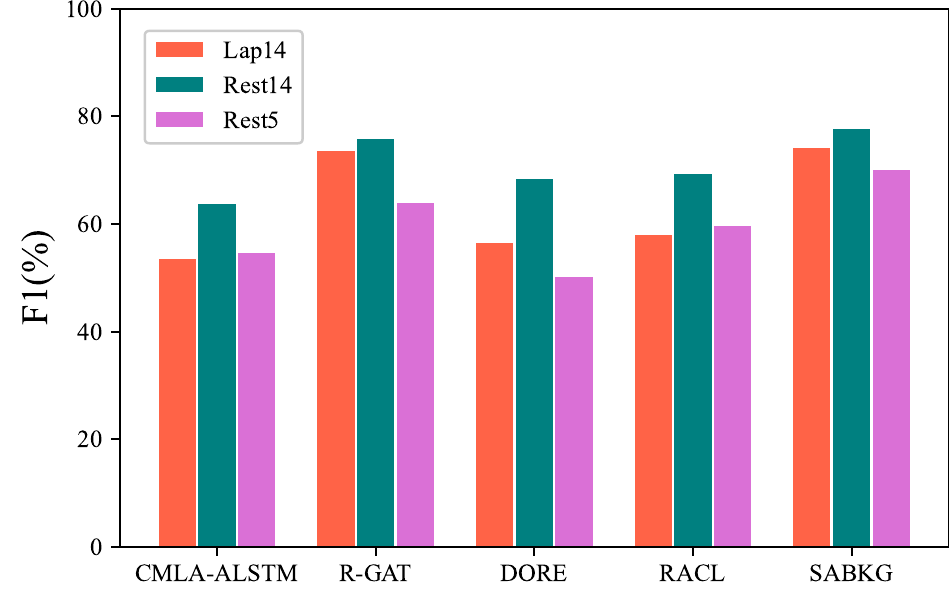
Figure 3. Comparison with Baseline